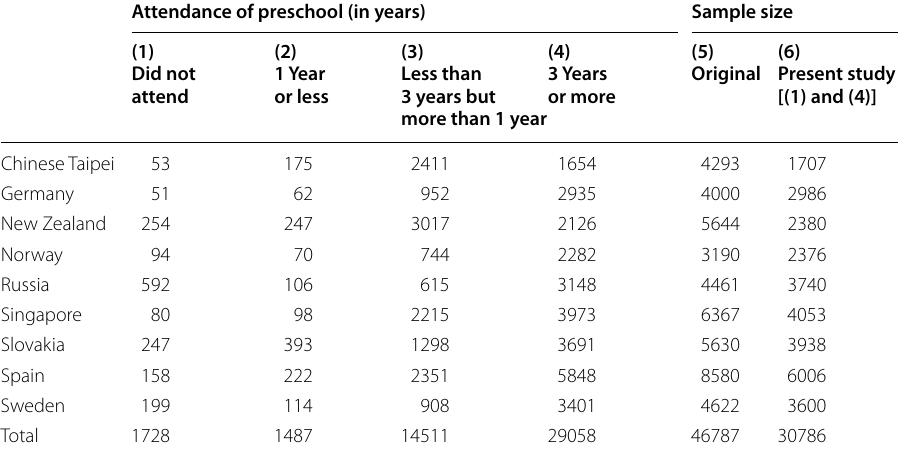
We used multiple imputations to replace missing data, and the reported frequencies are based on the combined results from the five imputed datasets (see the section on missing